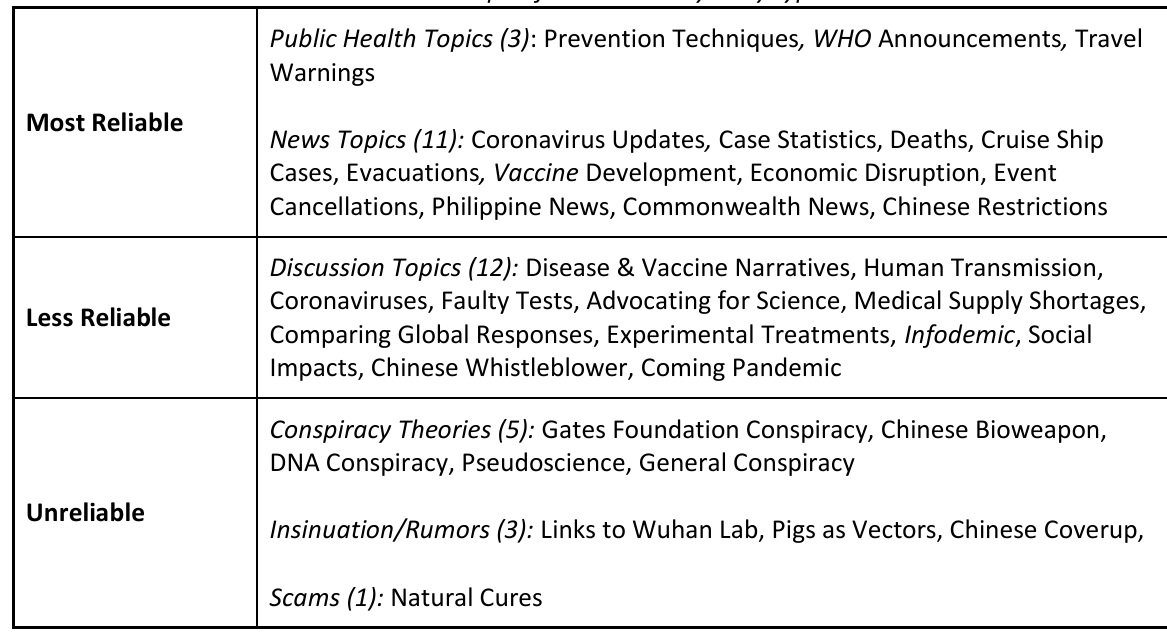
Table 2. Topics from LDA analysis by